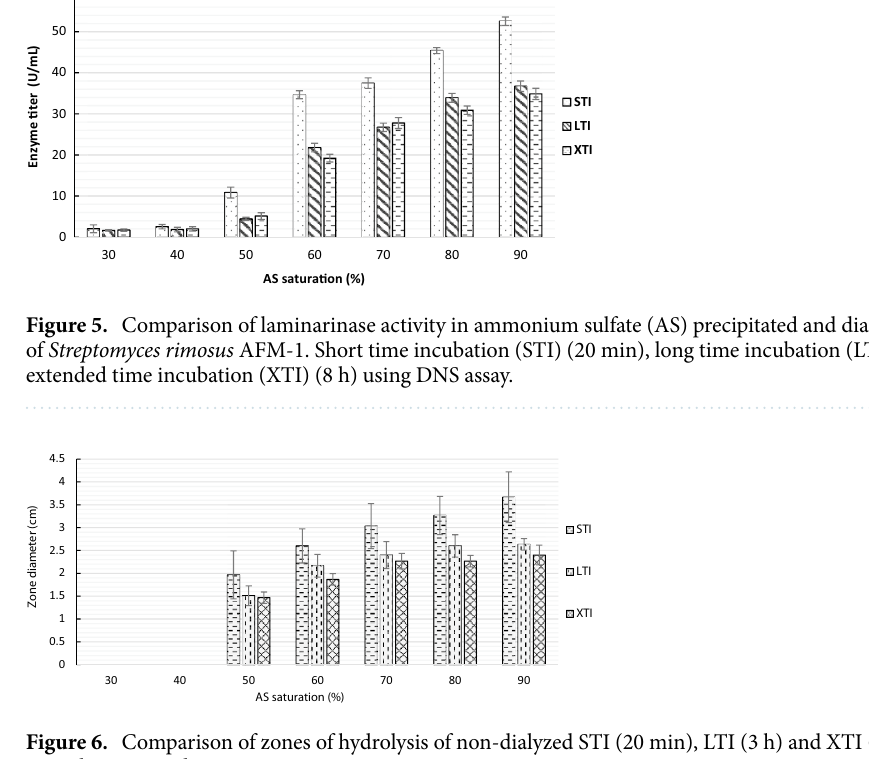
Figure 6. Comparison of zones of hydrolysis of non-dialyzed STI (20 min), LTI (3 h) and XTI (8 h) samples using laminarin plate